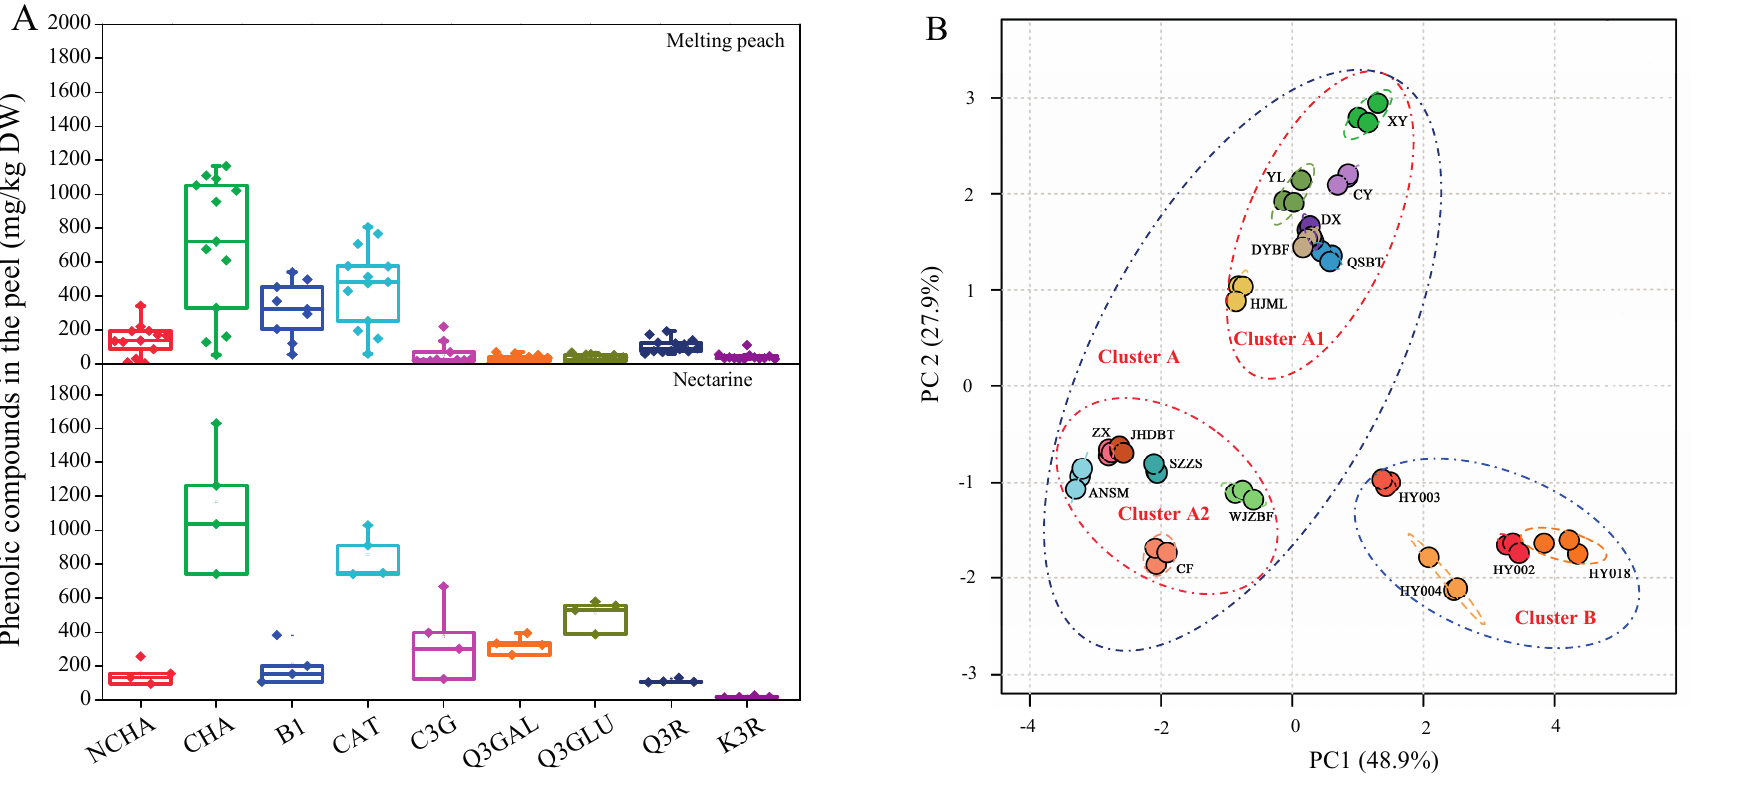
Figure 1. Analysis of the phenolic contents in the peel of 17 P. persica cultivars ( A ) and the classification of different fruit cultivars using principle component analysis (PCA) based on the phenolic profiles in the peach peel ( B